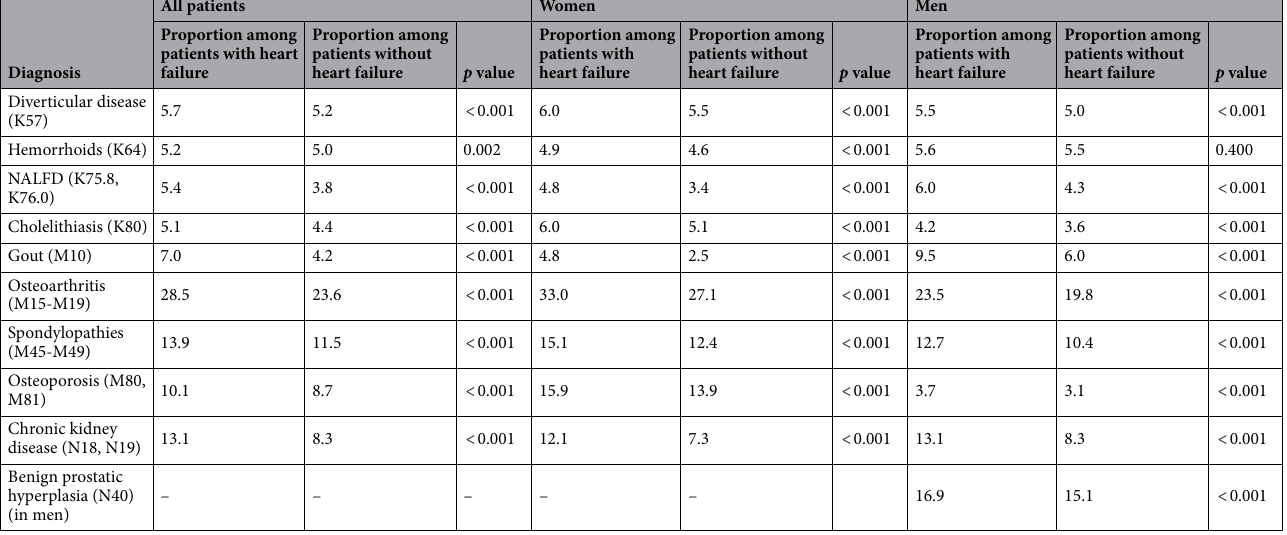
Table 2. Prevalence of different diagnoses documented within one year prior to the index date in patients with and without heart failure followed in general practices in Germany (multivariable logistic regression models).